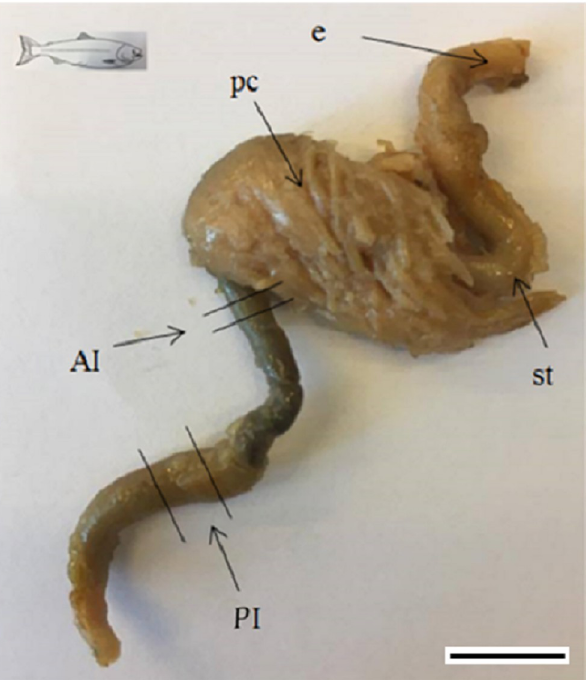
Fig 2. The complete gastrointestinal tract of Atlantic salmon divided into different parts. AI. anterior intestine; PI. posterior intestine; e. esophagus; pc. pyloric caeca; st. stomach. Scale bar represents 1 cm.